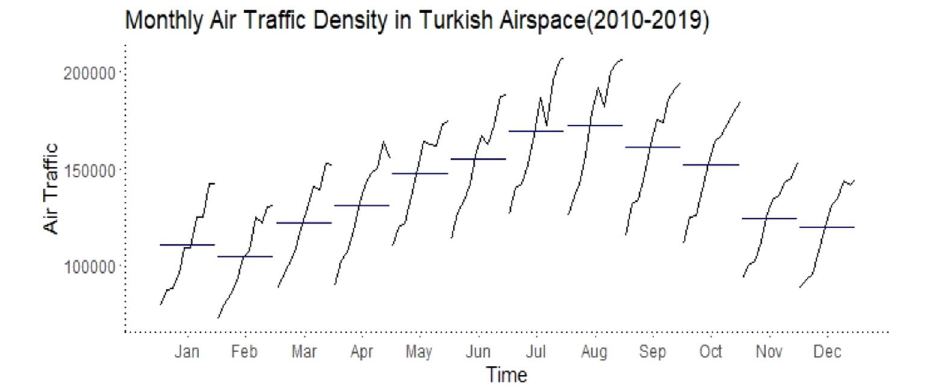
Figure 3. Monthly averages of air traffic data for the years